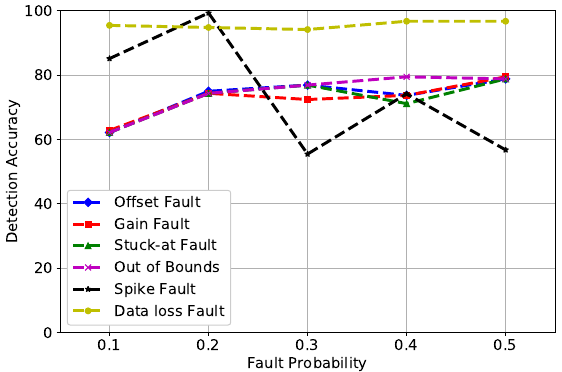
Figure 8. PNN detection accuracy of fault